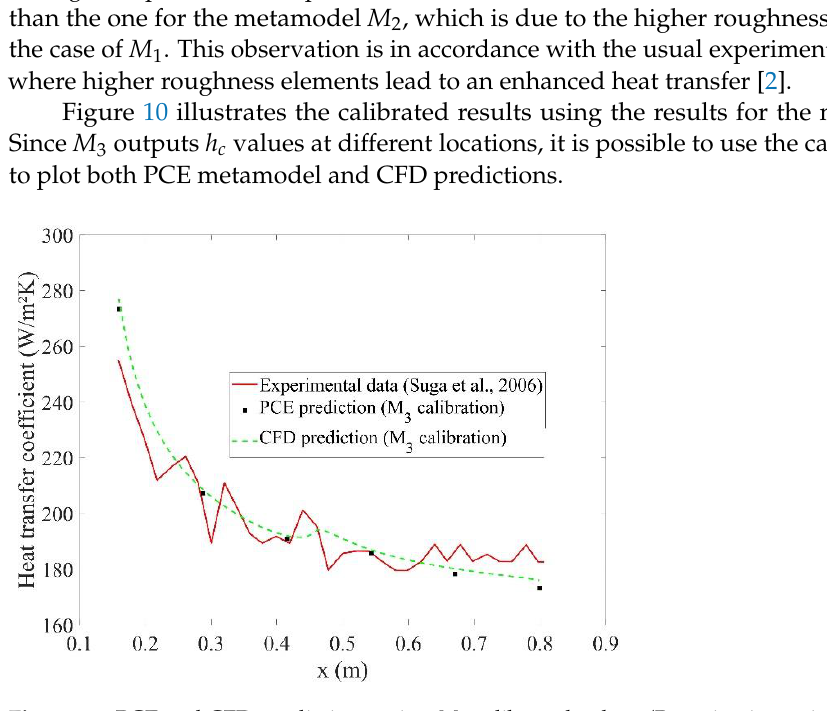
3 calibrated values (Bayesian